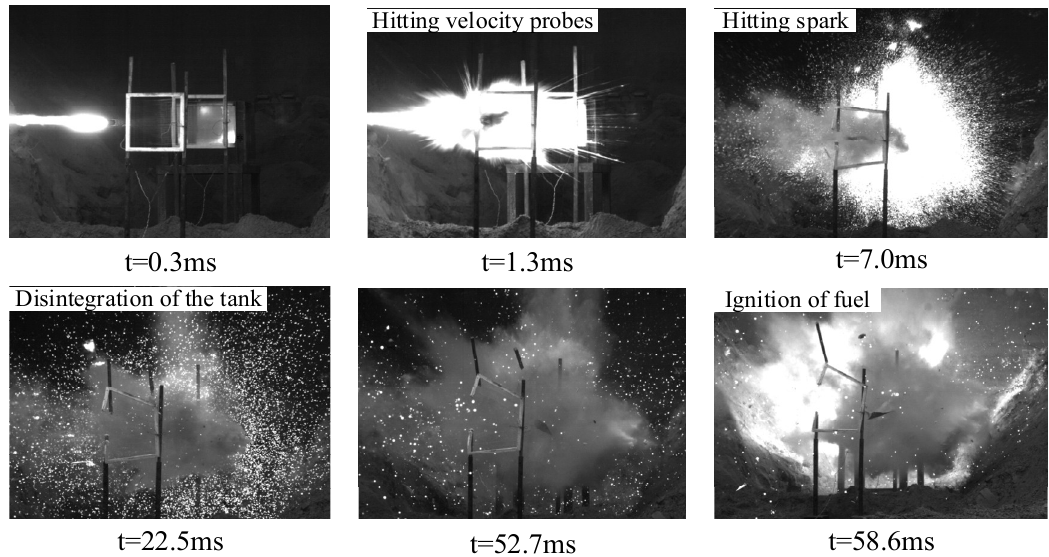
Figure 6. Damage to the fuel tank caused by steel fragments at medium and low speeds. ( a ) Damage to the fuel tank caused by the 10 g steel fragments at 1454 m/s; and ( b ) damage to the fuel tank caused by the 7 g steel fragments at 1868 m/s.